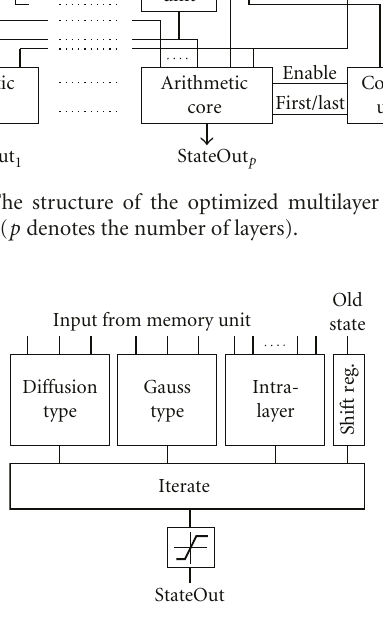
Figure 3: The block level structure of the optimized arithmetic core.